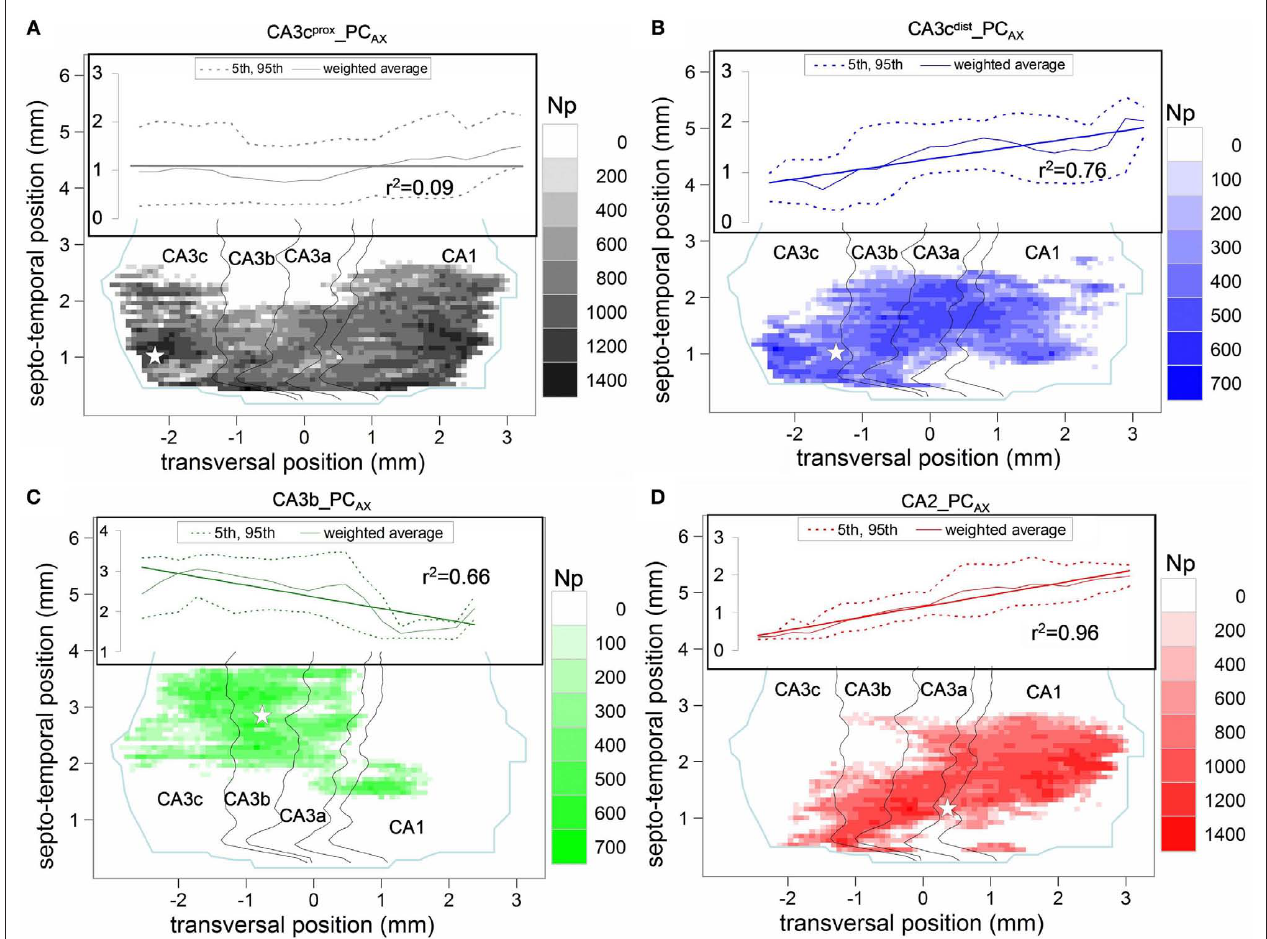
Figure 3 | Potential connectivity maps of four pre-synaptic CA3/2 principal neurons onto pyramidal cells. (A) CA3c prox _PC (C) CA3b_PC (green), and (D) CA2_PC (red). In all maps, the white star denotes the transversal and septo-temporal coordinates of the pre-synaptic soma. Insets AX AX show the linear regression and 95% confidence interval of the septo-temporal vs. transversal positions weight-averaged by the potential